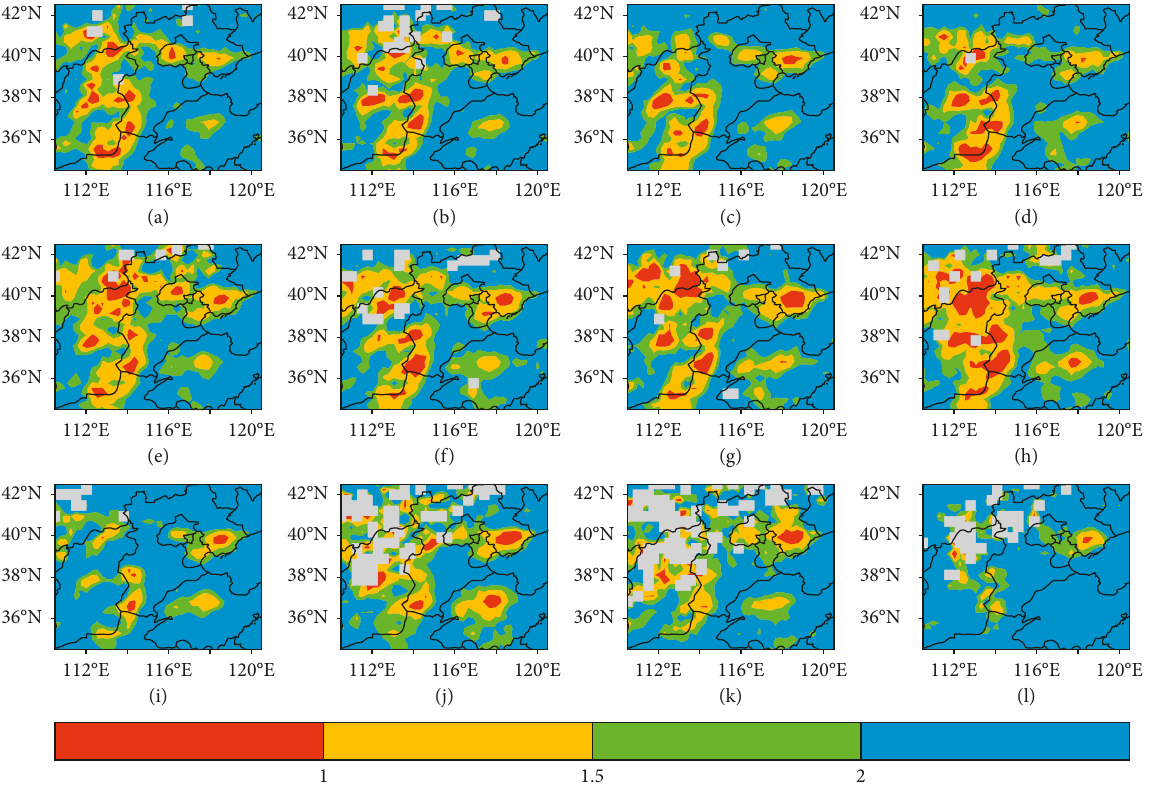
Figure 6: Average tropospheric FNR in JJA for 2005–2016. (a) 2005, (b) 2006, (c) 2007, (d) 2008, (e) 2009, (f) 2010, (g) 2011, (h) 2012, (i) 2013, (j) 2014, (k) 2015, and (l) 2016. FNR is defined as the ratio of tropospheric HCHO column concentration to tropospheric NO 2 column